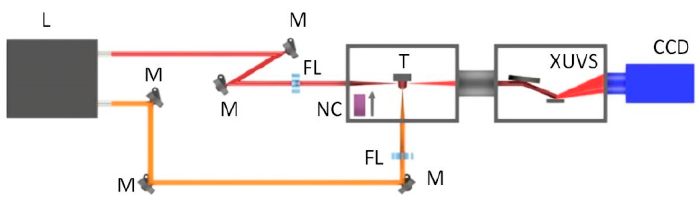
Figure 1. Experimental setup for high-order harmonic generation (HHG) in zinc-contained plasmas. L: laser; M: mirrors; FL: focusing lenses; NC: nonlinear crystal; T: target; XUVS: extreme ultraviolet spectrometer; CCD: charge-coupled device.